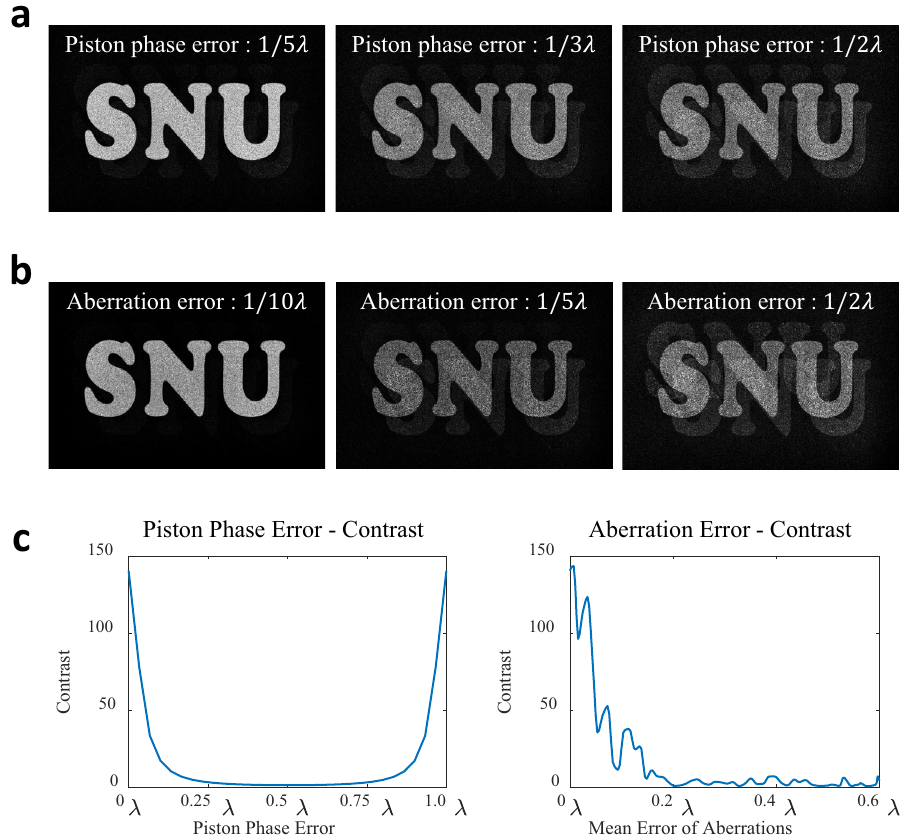
Figure 7. Simulation results for analyzing the factors affecting crosstalk. The reconstructed images with crosstalk according to ( a ) the piston error and ( b ) the aberration error. ( c ) Weber contrast versus the piston error and the aberration